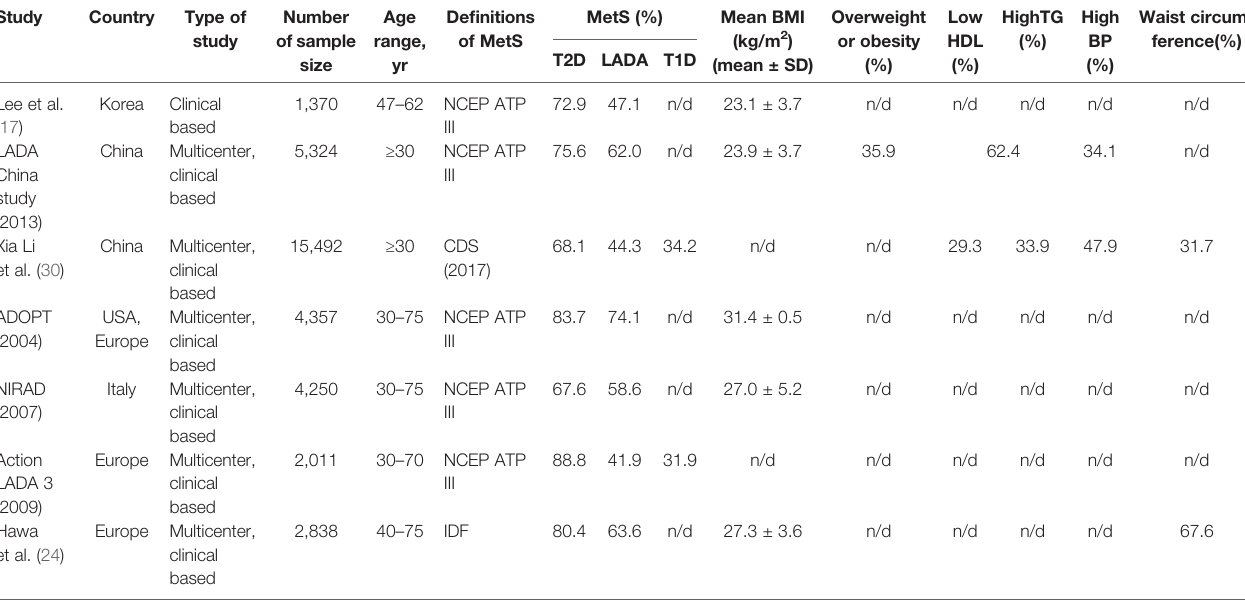
TABLE 2 | The prevalence of MetS in T2DM, LADA, and